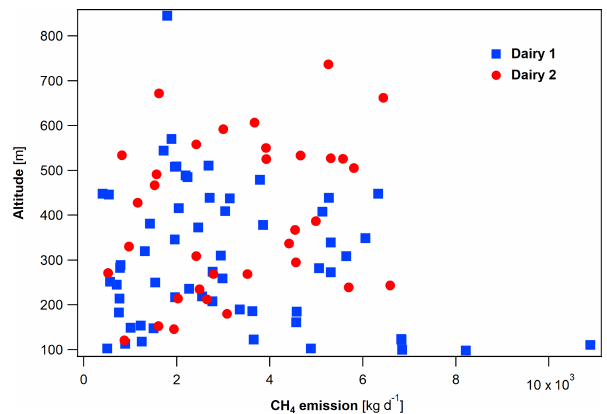
Figure 6. Observed methane emissions (CH 4 ; kgd − 1 ) plotted by aircraft altitude at both dairy farms (Dairy 1 and Dairy 2). Emission rates are distributed randomly across hundreds of meters in altitude with a handful of outliers at lower and higher